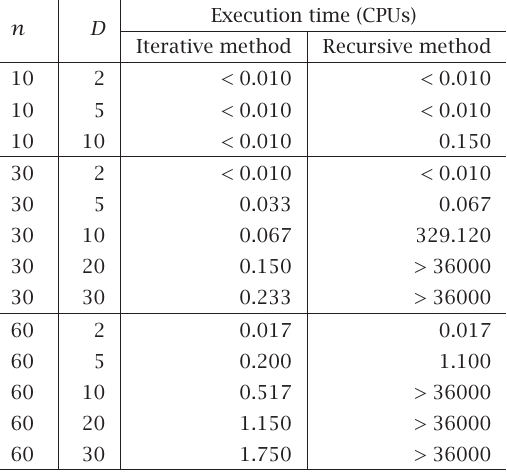
Table 5.1 . Execution times for evaluating complete graph